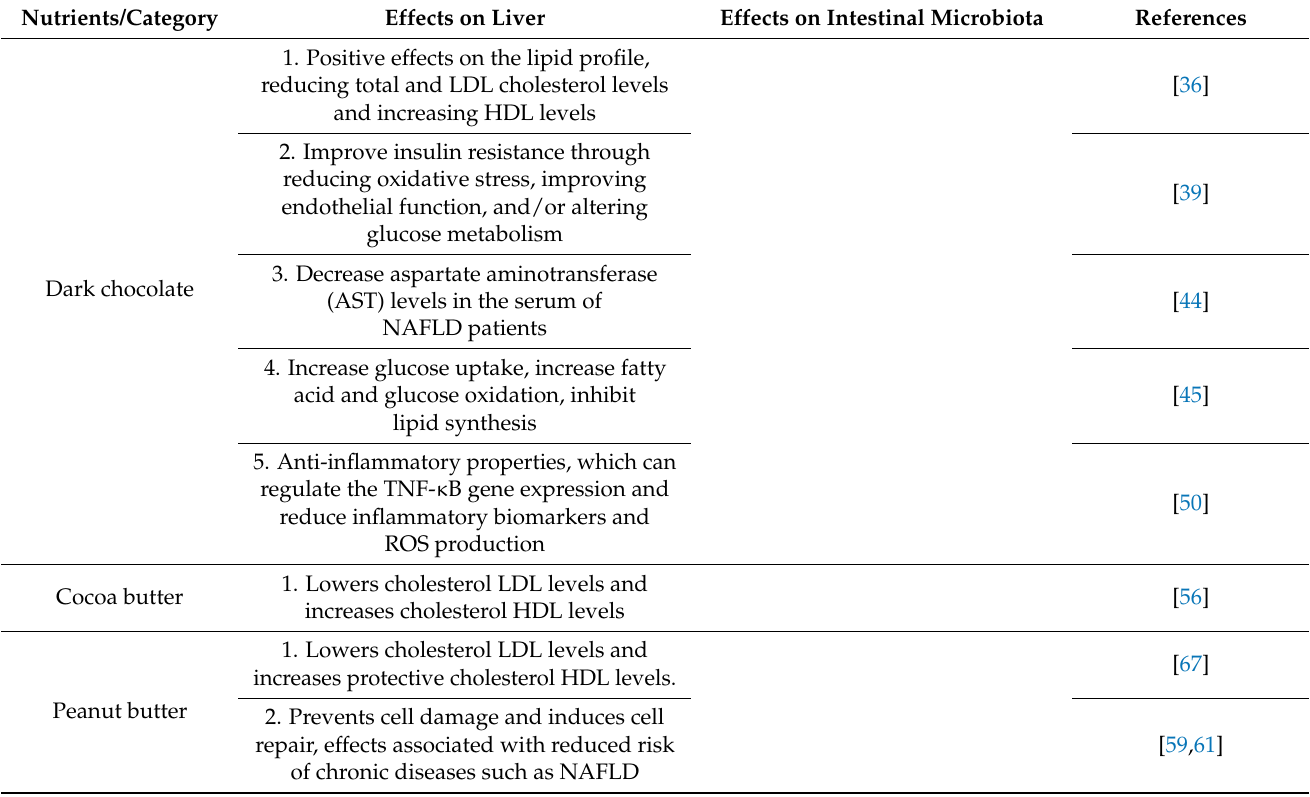
Table 1. The influence of bioactive aliment compounds on NAFLD.